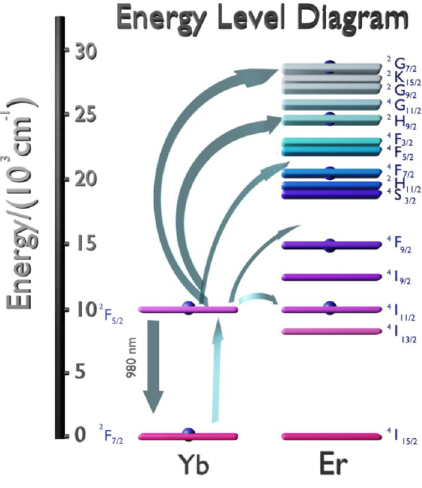
Fig. 2 Energy diagram for Er–Yb energy transfer